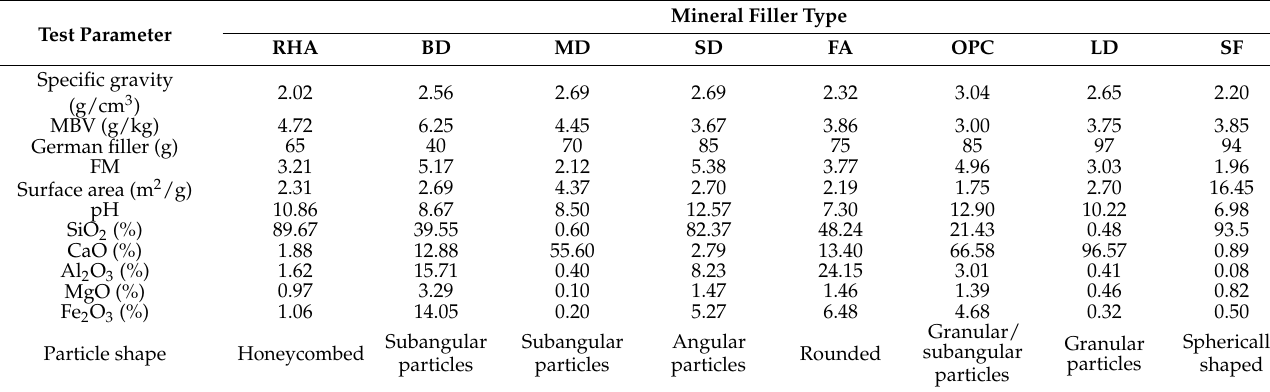
Table 3. Properties of the investigated mineral